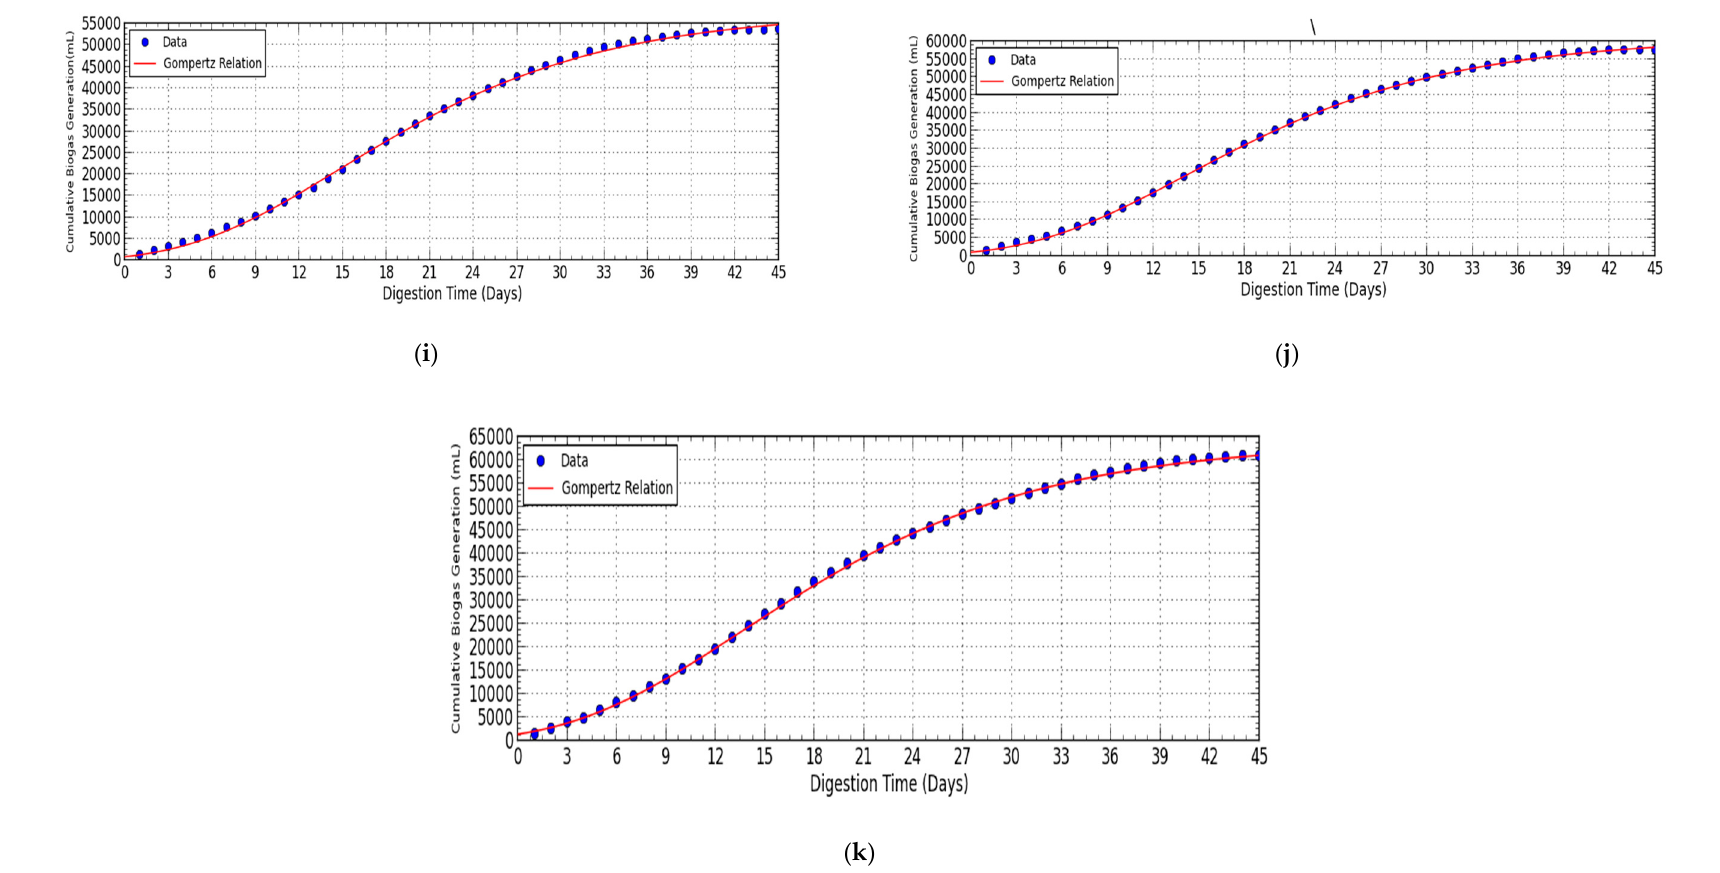
Figure 8. The cumulative biogas profile for experimental and predicted values by using Gompertz model for pretreated food waste at different pressures and time intervals. ( a ) Untreated food waste; ( b ) pretreatment at 0.5 kg/cm 2 ; ( c ) pretreatment at 1 kg/cm 2 ; ( d ) pretreatment at 1.5 kg/cm 2 ; ( e ) pretreatment at 2 kg/cm 2 ; ( f ) pretreatment at 2.5 kg/cm 2 ; ( g ) pretreatment for 20 min; ( h ) pretreatment for 40 min; ( i ) pretreatment for 60 min; ( j ) pretreatment for 80 min; ( k ) pretreatment for 100 min.